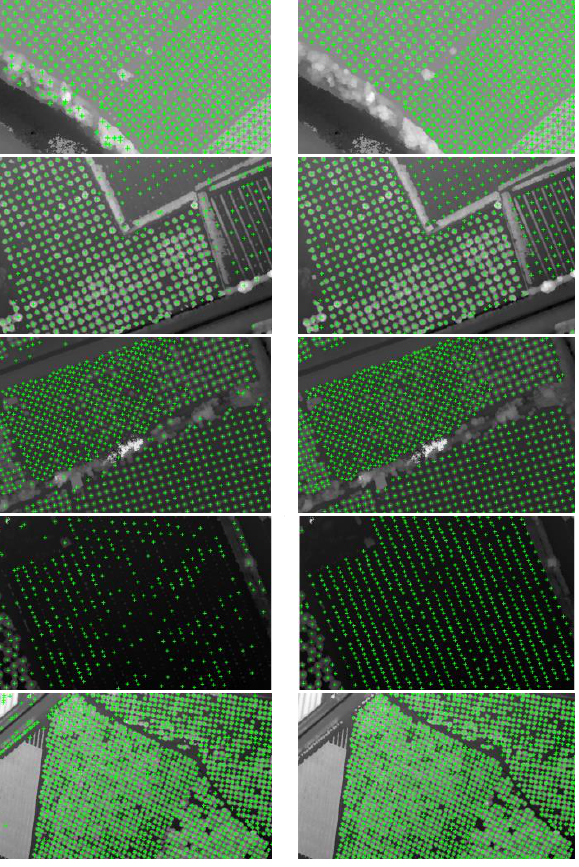
Figure 5. ( left column ) The results of proposed approach, and ( right column ) the reference data.